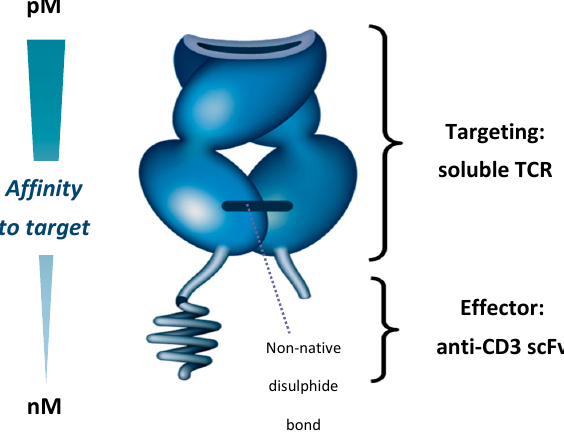
Figure 1. Immune-mobilising monoclonal T cell receptor against cancer (ImmTAC) molecule showing T cell receptor (TCR) targeting domain and effector anti-CD3 scFv. scFv—Single-chain variable fragment; TCR, T cell receptor.